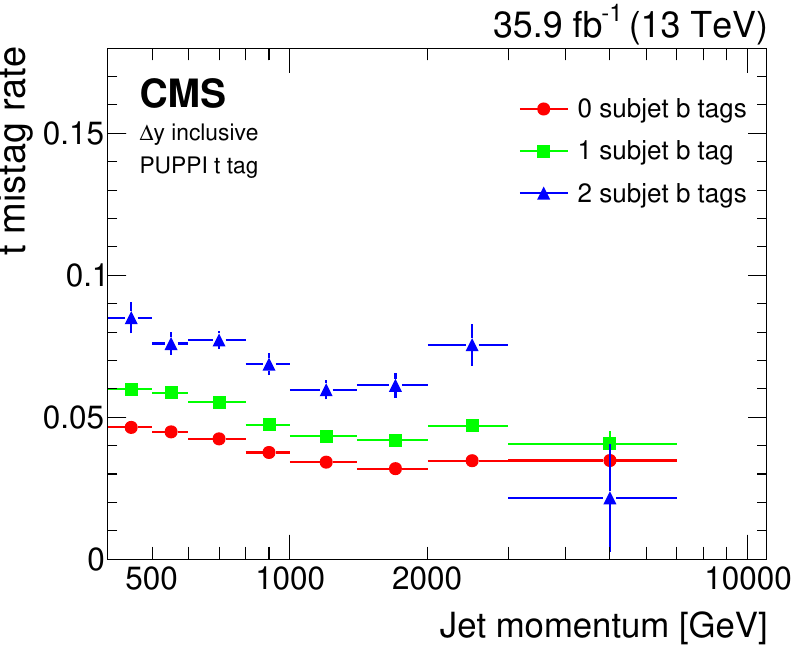
Figure 7 . The t mistag rate as measured with an anti-tag and probe procedure separately for each b-tag